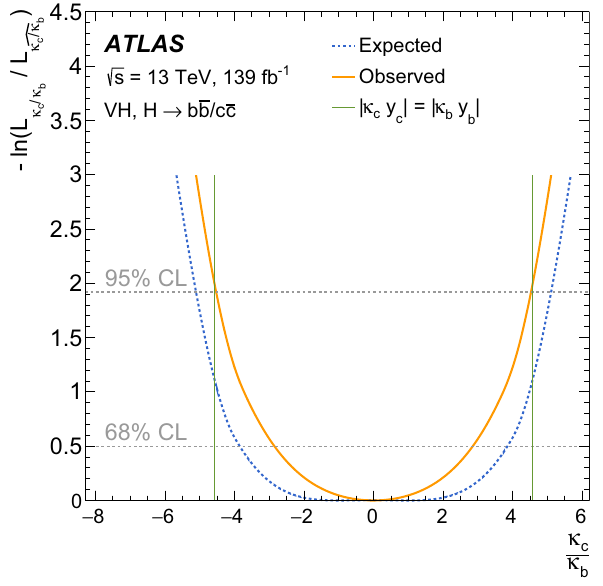
Fig. 7 Expected and observed values of the combined V H , H → c ¯ c and V H , H → b ¯ b negative profile log-likelihood ratio as a function of κ /κ κ c b , where b is a free parameter. The vertical green lines correspond to the values of | κ c /κ b | for which the Higgs–charm and Higgs–bottom couplings are equal, where each coupling strength | κ i y i | is the product of the κ i modifier and the Yukawa coupling, y i , for i = b , c , and is equal to m b / m c = 4 . 578 ± 0 . 008